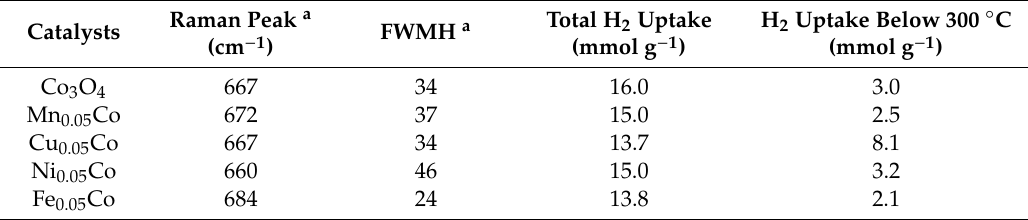
Figure 4. Raman spectra of the Co 3 O 4 and M 0.05 Co catalysts. Table 2. Raman and temperature-programmed reduction in hydrogen (H 2 -TPR) analysis of the Co 3 O 4 and M 0.05 Co catalysts.